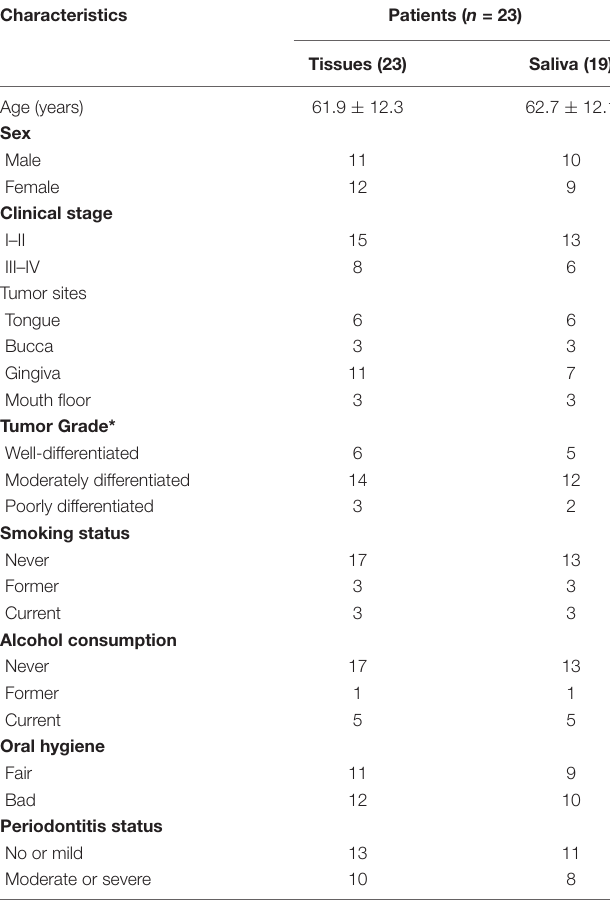
TABLE 1 | Clinical characteristics of SCC subjects participating in the